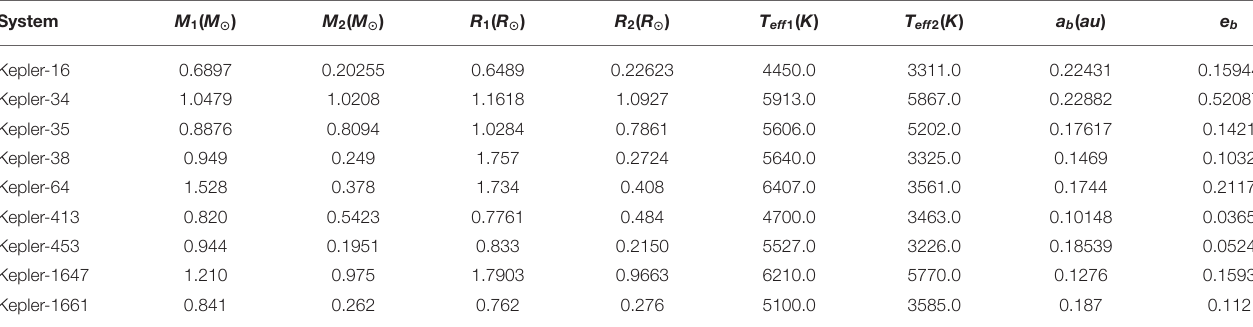
TABLE 1 | Mean physical parameters and orbital elements for the Kepler-16(AB), Kepler-34(AB), Kepler-35(AB), Kepler-38(AB), Kepler-64(AB), Kepler-413(AB), Kepler-453(AB), Kepler-1647(AB), and Kepler-1661(AB) stellar binaries.